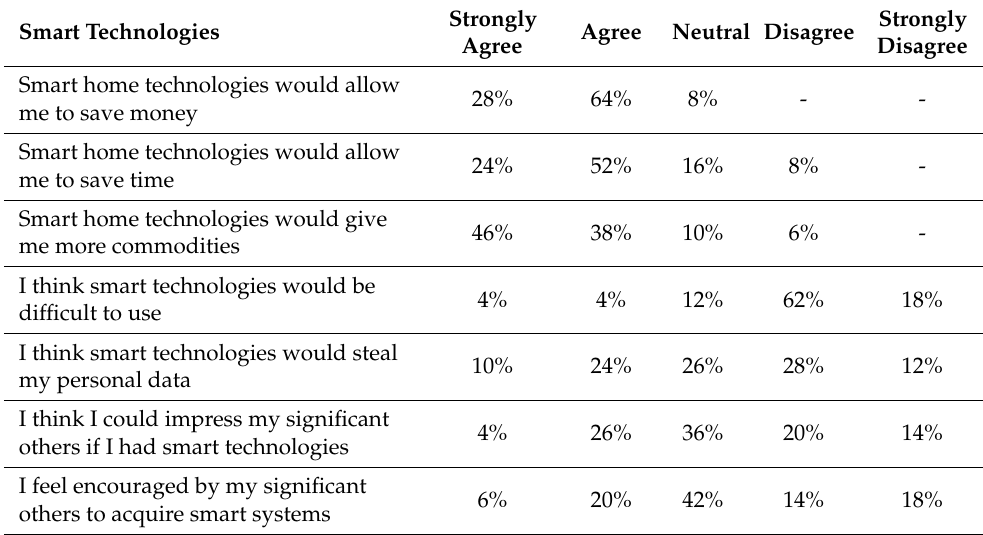
Table A1. Sentences about smart technologies—answers collected on a 5-point Likert scale.